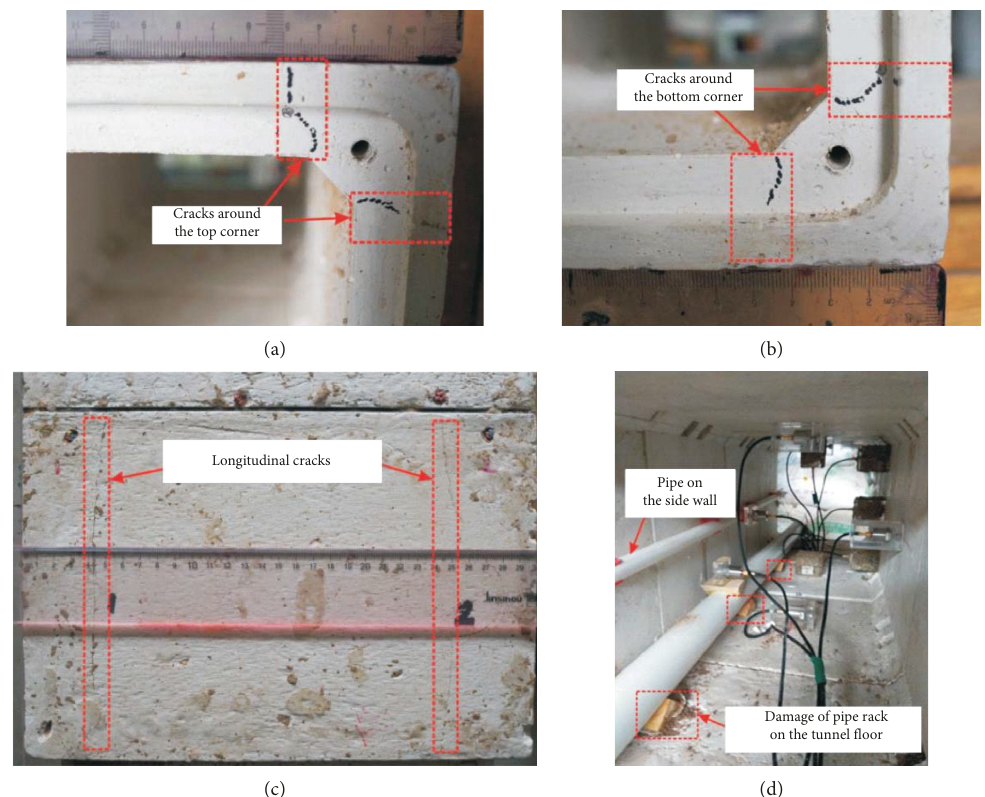
Figure 17: Damage phenomena in the test. (a–c) Cracks on the model structure. (a) Cracks around the top corner. (b) Cracks around the bottom corner. (c) Longitudinal cracks. (d) Damage of pipeline